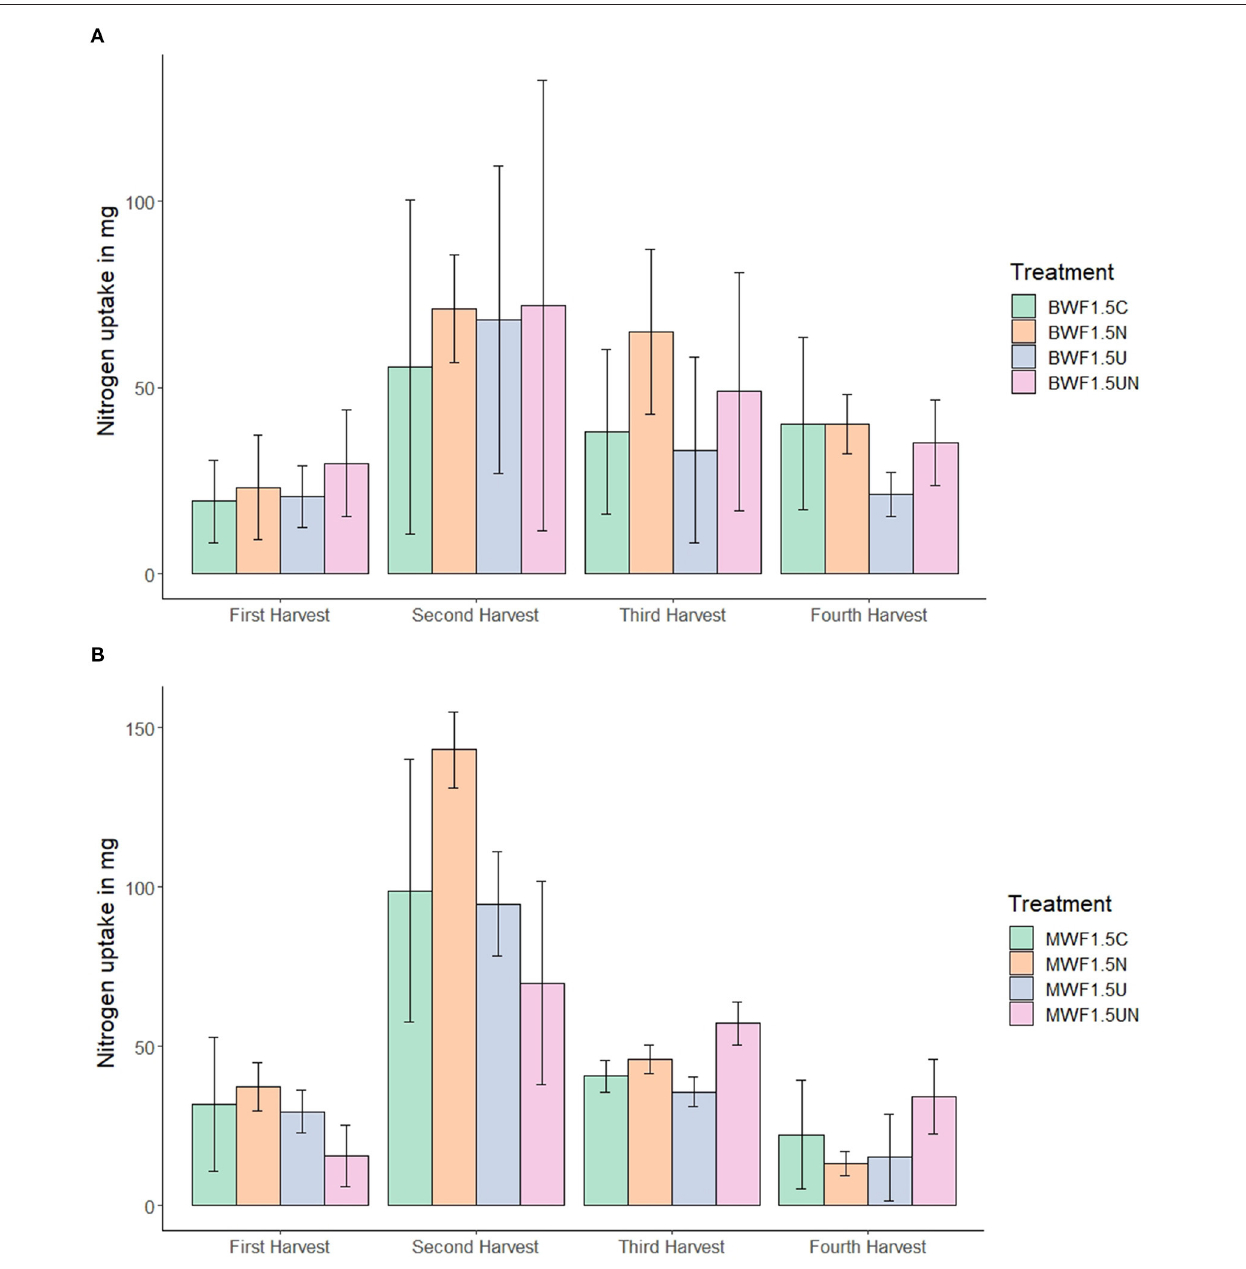
FIGURE 2 | N uptake in Italian ryegrass shoot biomass at four different harvest dates (mean ± 95% confidence interval for n = 5) in replicates fertilized with 1.5% (w/w) buffalo worm frass, BWF (A) or mealworm frass, MWF (B) . Pots were amended with frass alone, or concurrently with nitrification inhibitor (NI), urease inhibitor (UI), or